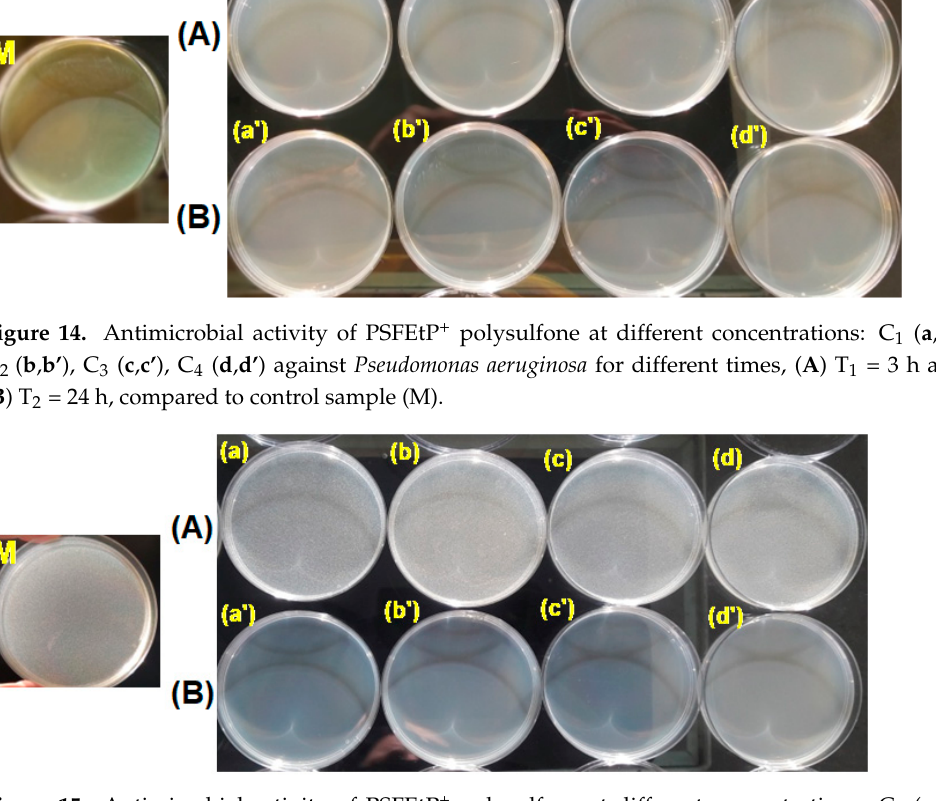
Figure 15. Antimicrobial activity of PSFEtP + polysulfone at different concentrations: C 1 ( a , a’ ), C 2